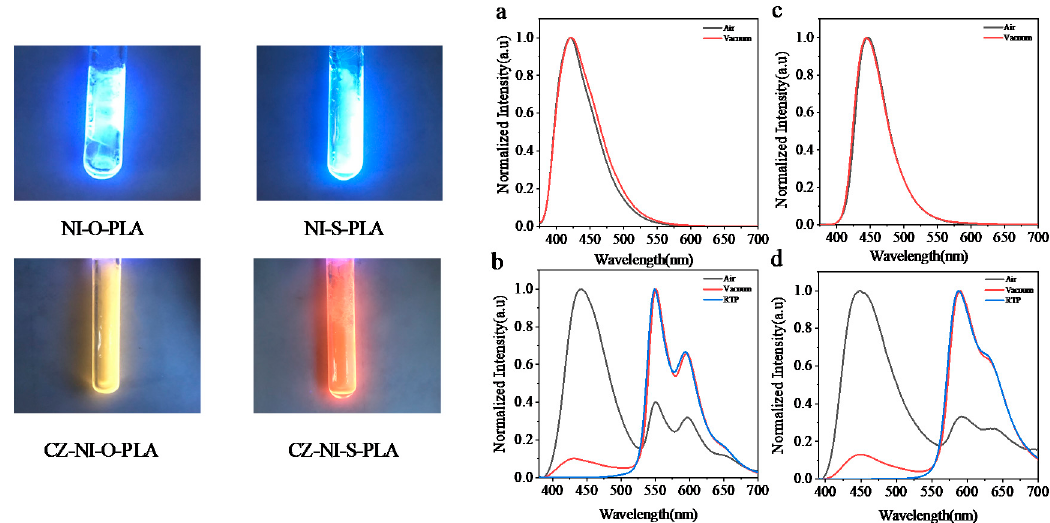
Figure 2. Left: photoluminescence photos of four polylactides films; Right: steady-state emission spectra of NI-O-PLA ( a ) and NI-S-PLA ( c ); CZ-NI-O-PLA ( b ) and CZ-NI-S-PLA ( d ) steady-state emissions and RTP spectra.